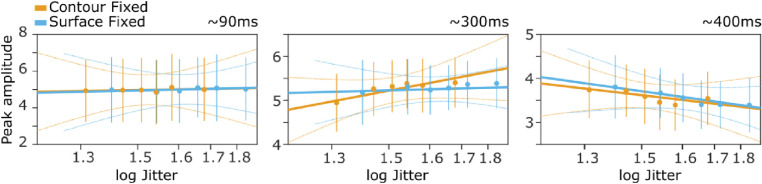
Temporally aligned peak amplitudes as a function of cue jitter. Error bars indicate 95% confidence intervals (CIs), thin lines reflect 95% CI of the estimated regression lines. The only negative association between VEP amplitude and cue jitter was found at a positive component peaking at around 400 ms after stimulus onset (P400).